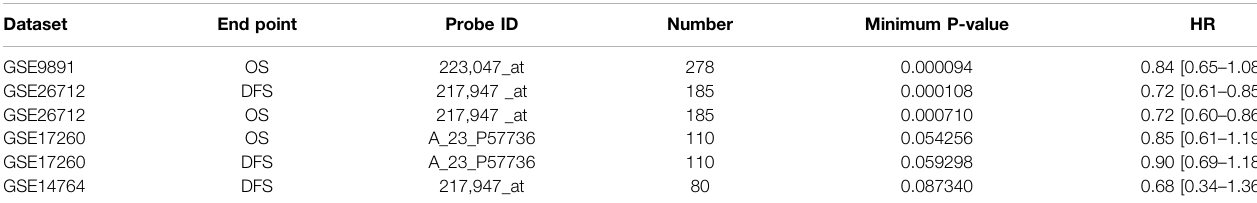
TABLE 2 | CMTM6 expression and survival data of OV by the PrognoScan database.